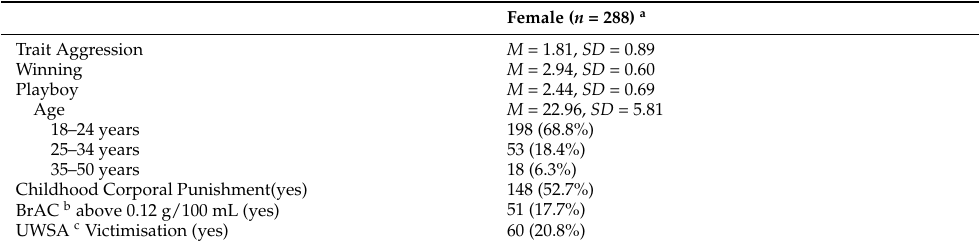
Table 1. Sample Demographic Information for Female